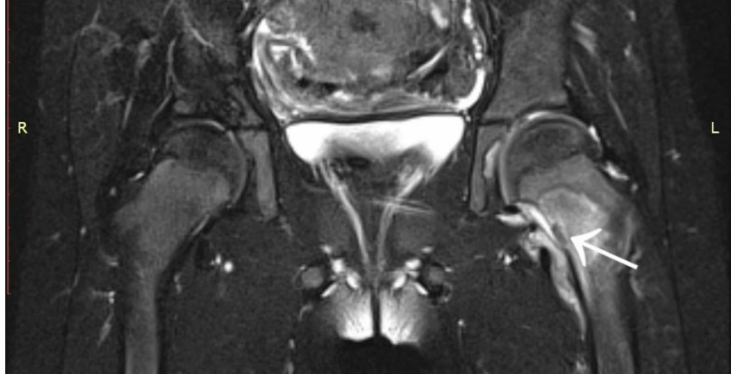
Figure 5. MRI scan showing a focus of OO (arrow) in the left femoral neck.